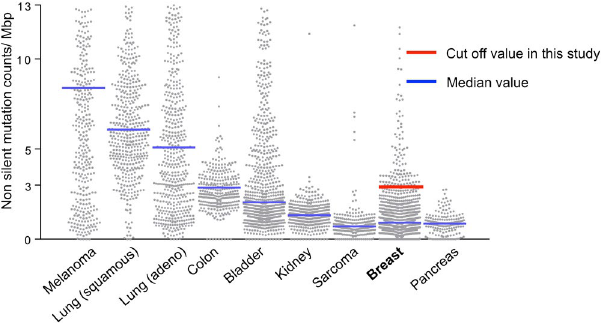
Figure 1. Non-silent mutation count distribution in TCGA multiple cancer cohorts, the top 10% of the non- silent mutation counts, rounded to 3/Mbps (red bar), is defined as BCs with high mutation rates in the present study. Blue bar represents the median values. TCGA, The Cancer Genome Atlas; Mbps, Mega base pairs; BC, breast